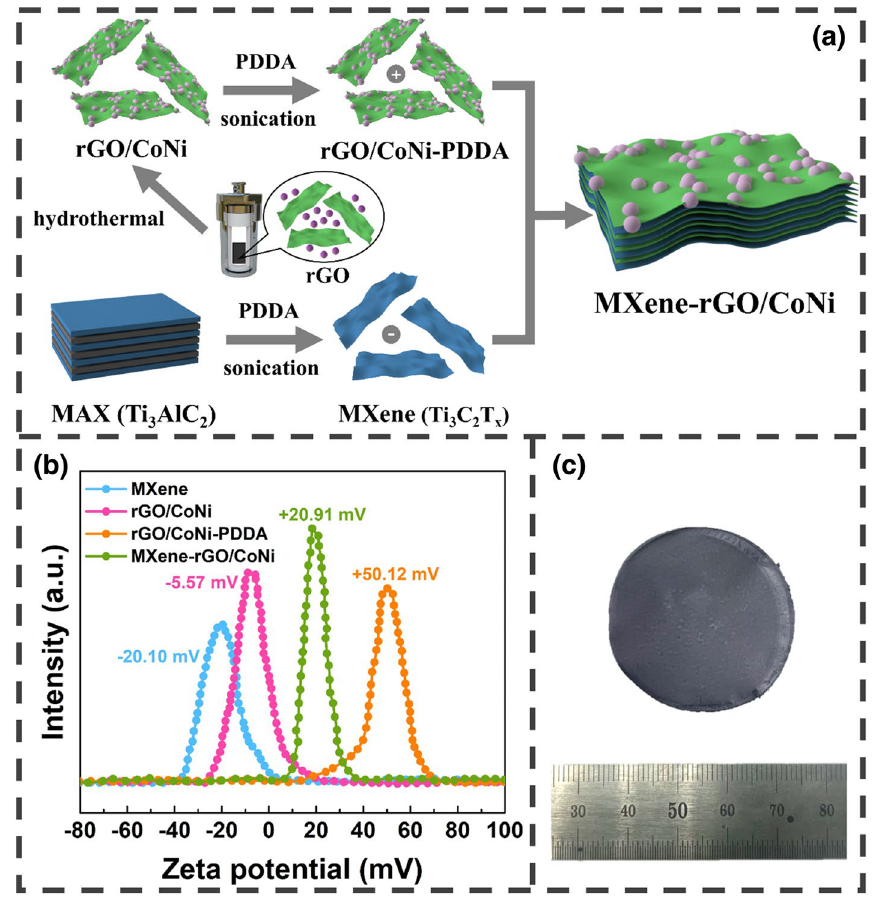
Fig. 1 a Schematic illustration for the synthesis of the MXene-rGO/CoNi hybrids; b zeta potential of MXene, rGO/CoNi, rGO/CoNi-PDDA and self-assembled MXene-rGO/CoNi hybrid; c photograph of the MXene-rGO/CoNi